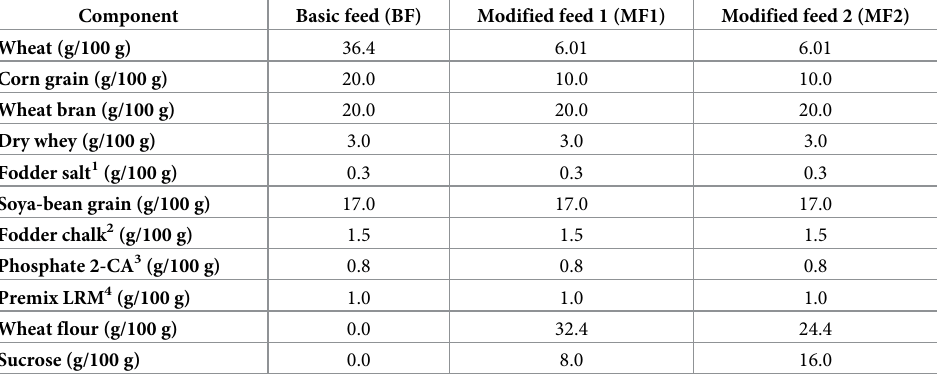
Table 1. Component composition of